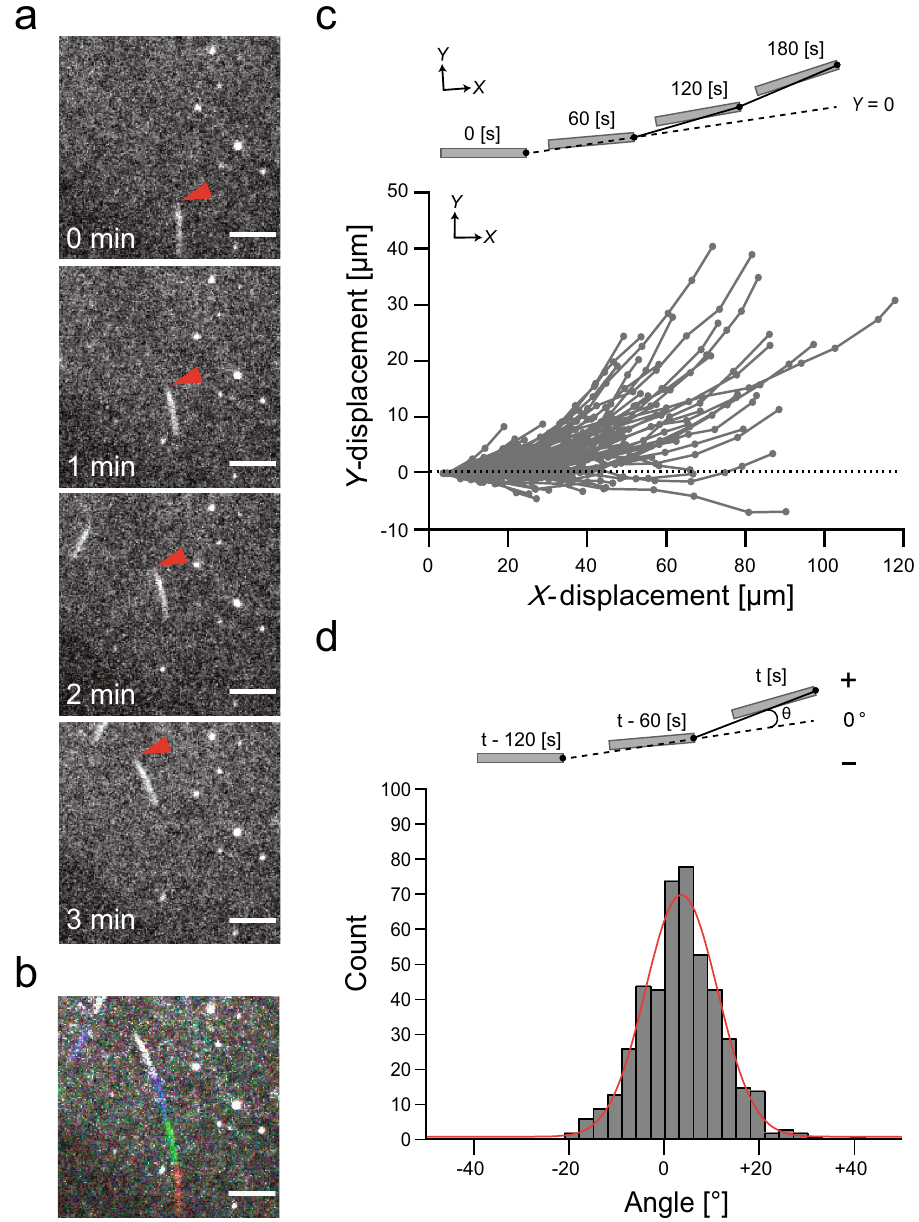
Figure 3. Circumferential gliding movement of microtubules driven by OAD. ( a ) Sequential images of rhodamine-labeled microtubule gliding driven by OAD. The solid arrowheads indicate the leading tip of the microtubule. Scale bar, 10 μm. ( b ) Superimposing successive images of a gliding microtubule driven by OAD taken every 1 min for 3 min. The first image is shown in red. Scale bar, 10 μm. ( c ) (Top) For each microtubule, the line connecting the microtubule tip in the first and second frames was defined as the y -axis (dotted line, y = 0), and the x–y position of the microtubule tip in each frame measured every 60 s was plotted. (Bottom) x – y trajectories of the tip of the gliding microtubules driven by OAD. The x–y position of the forward tip of the gliding microtubule to the left with respect to the gliding movement in the forward direction was expressed as a positive number ( n = 97 microtubules). ( d ) (Top) The angle between the line (solid line) defined by the front positions of the microtubule in each frame and in one previous frame, and the line (dotted line) defined by the front positions of the microtubule in one previous frame and in two previous frames were measured. (Bottom) Histogram of the direction angle of gliding microtubules every 60 s. The mean angular change was obtained from Gaussian fitting to the histogram of angular change per frame, giving values of + 3.4° every 60 s ( n = 458 angles). The plus (+) and minus (−) signs refer to the left and right side of the